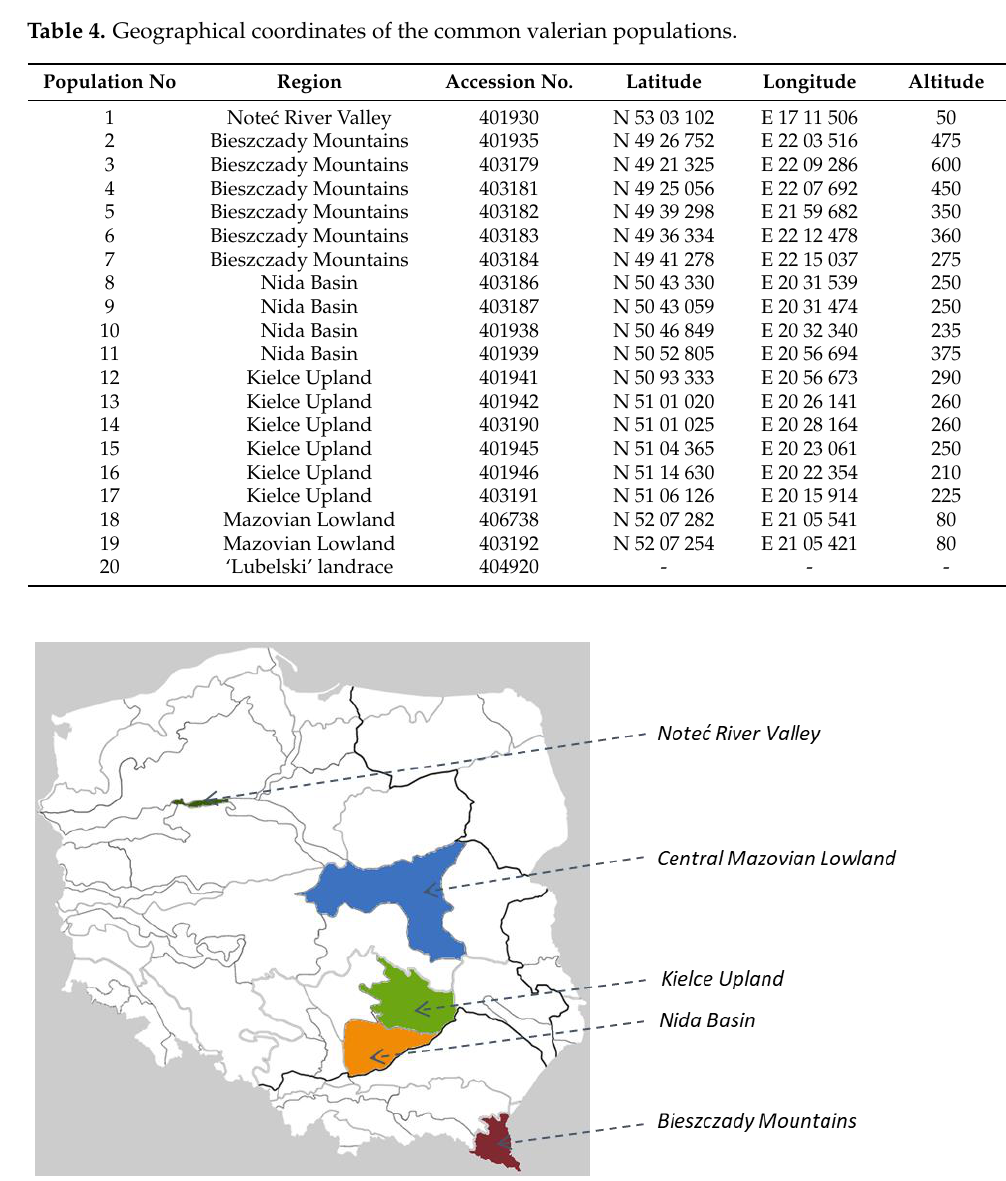
Figure 3. Geographical localization of the natural sites of the common valerian populations.